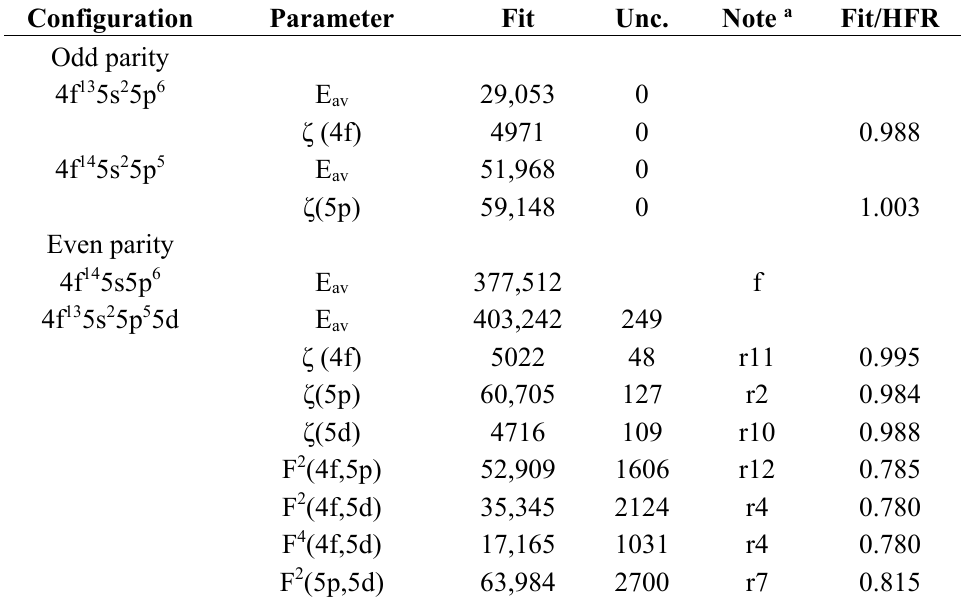
Table 1. Numerical values (in cm − 1 ) of the radial energy parameters adopted in the Hartree-Fock (HFR)